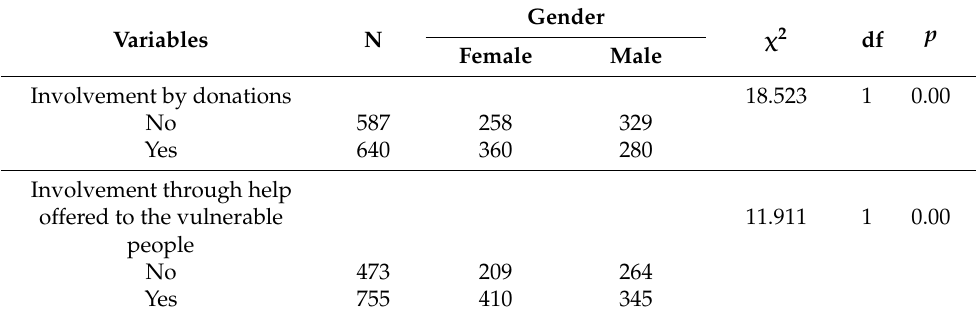
Table 4. Personal